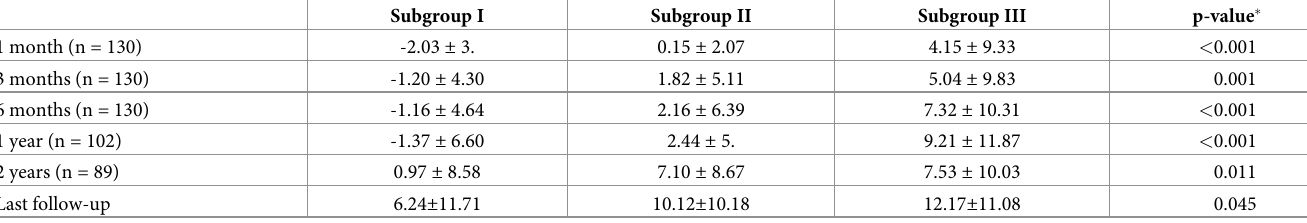
Table 4. Postoperative mean angle of deviation at distance in group Y (under 4 years of age) (N = 130).